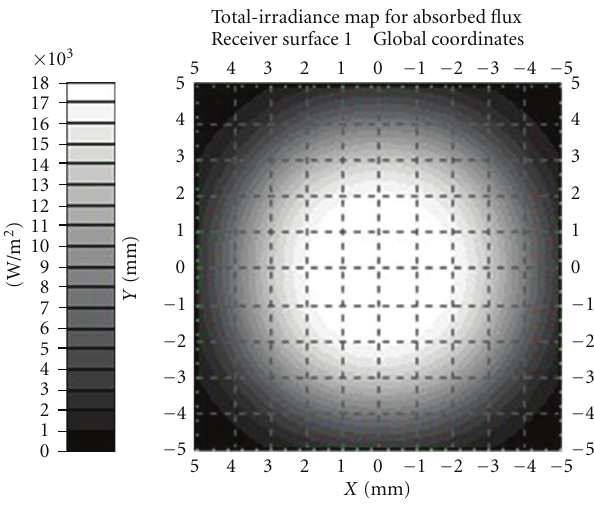
Figure 4: The illumination map on the receiver surface.